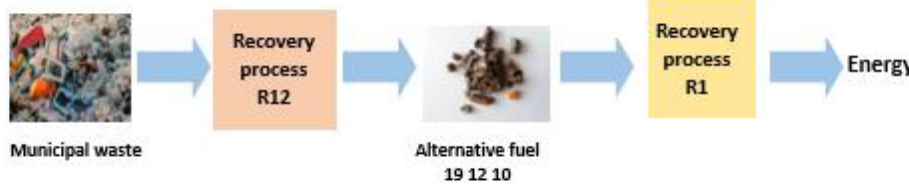
Figure 4. Qualification of recovery operations related to energy recovery of waste [25].